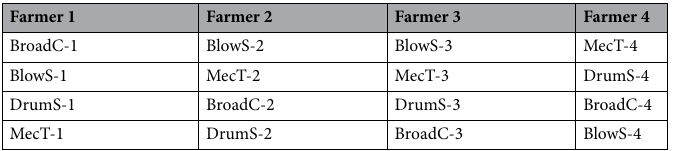
Table 1. Distribution of the treatments and replications in the experiment plots. BroadC = manual broadcasting, BlowS = blower-seeding, DrumS = drum-seeding, MecT = mechanized transplanting; the numbers associated with the treatments in the Table (i.e. 1, 2, 3, and 4) represent for the blocks or farmers, correspondingly.